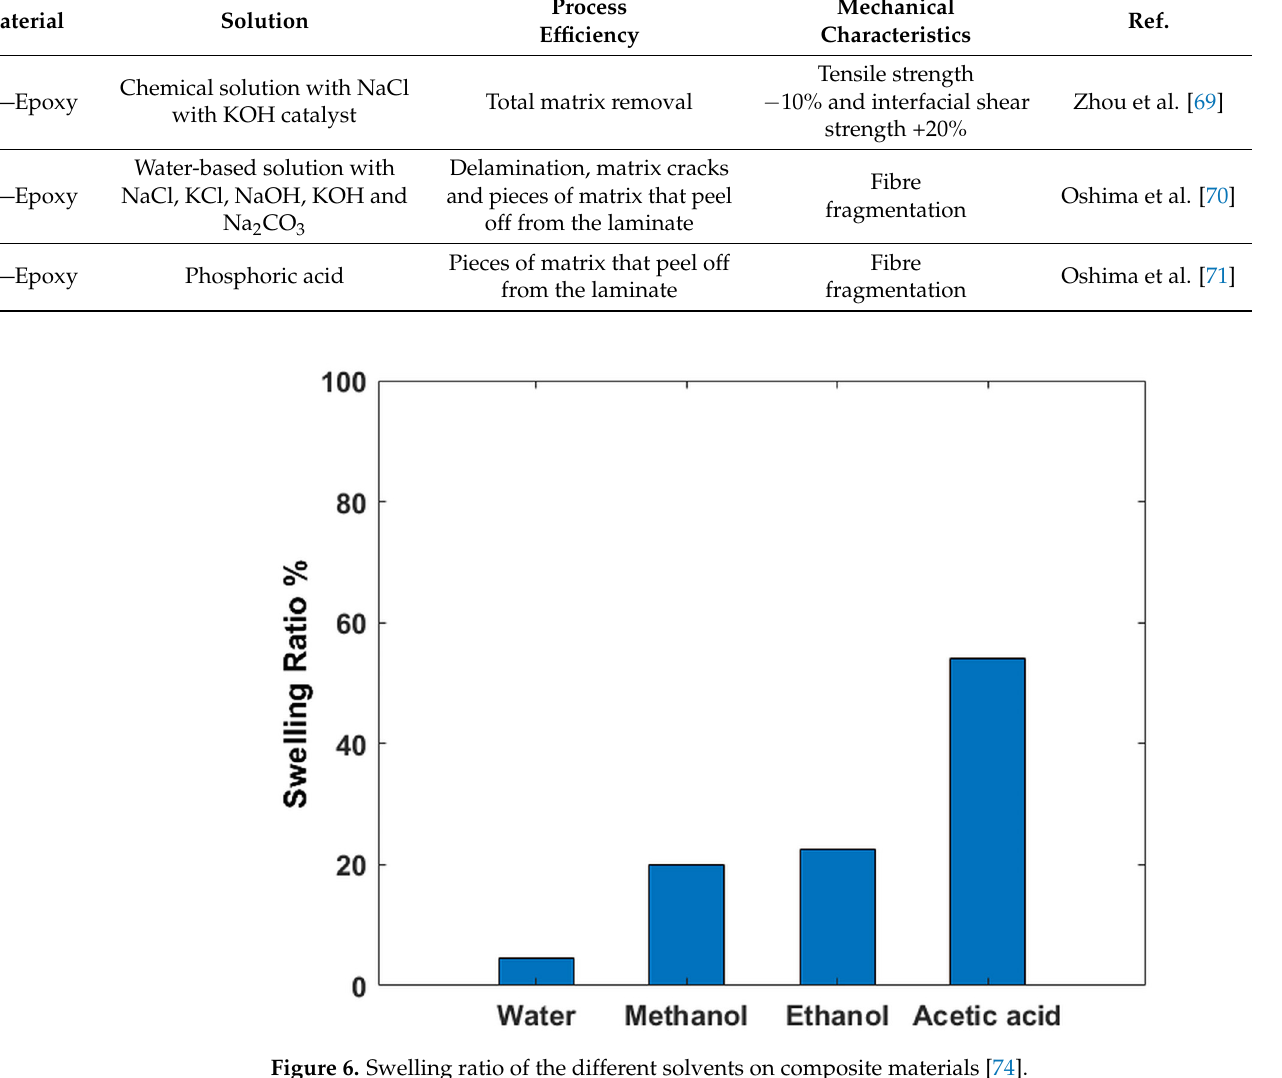
Figure 6. Swelling ratio of the different solvents on composite materials [74].